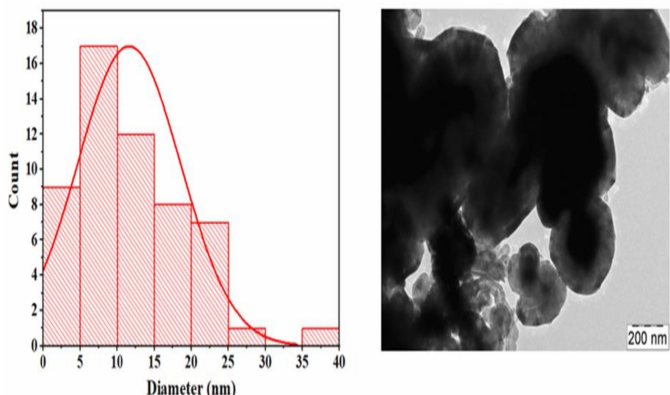
Figure 7. TEM of fresh CeNi 0.9 Zr 0.1 O 3 .